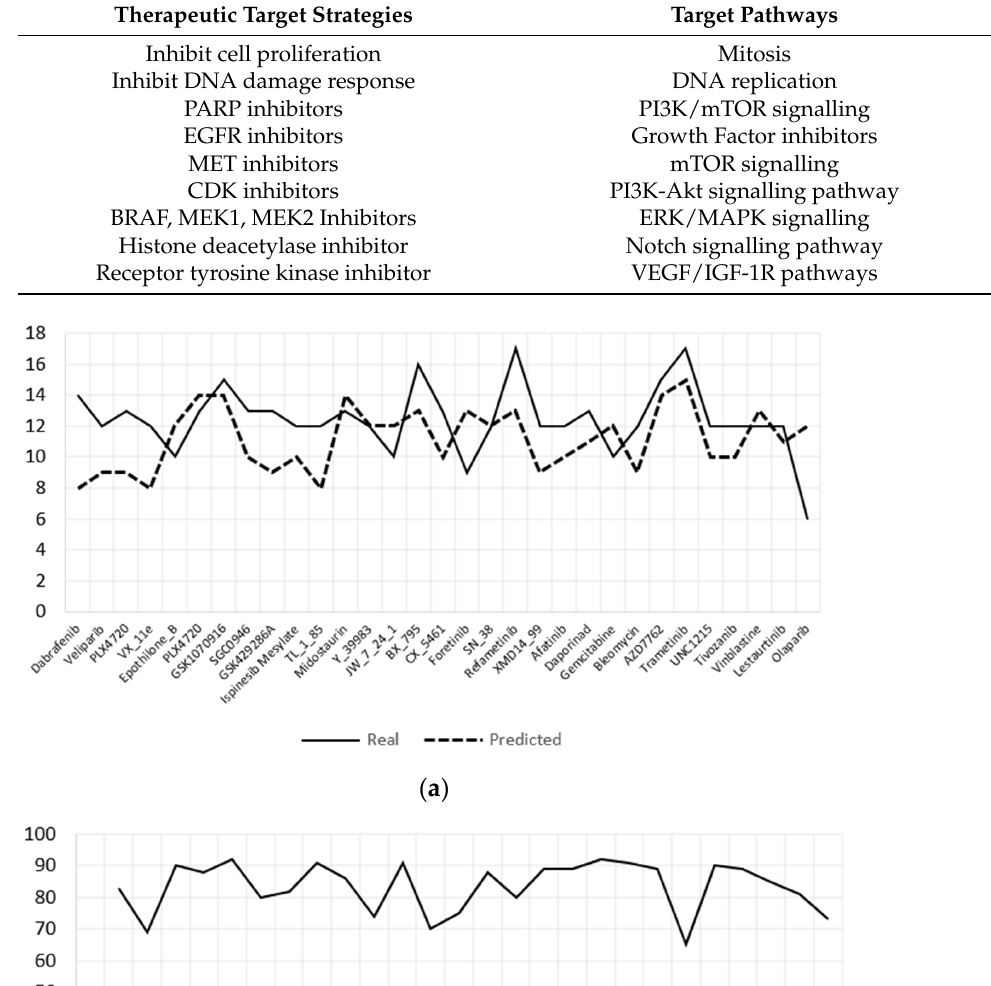
Table 4. Summary of therapeutic strategies and target pathways for BLBC.